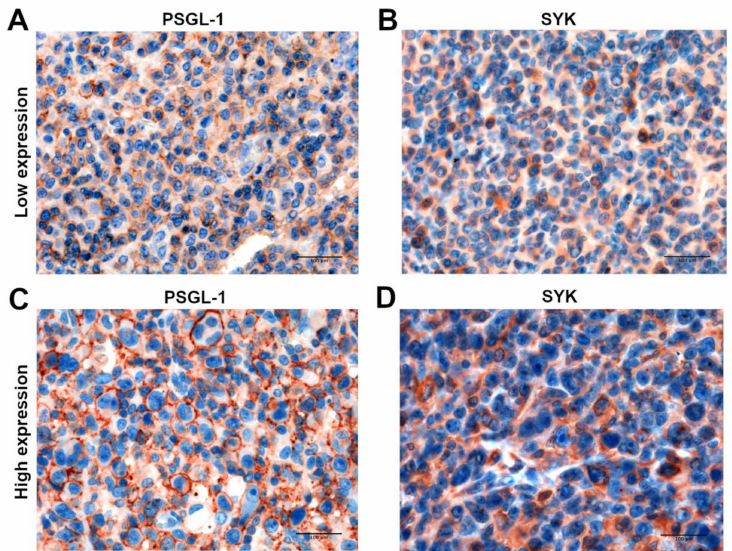
Figure 5. In situ IHC expression of PSGL-1 and SYK in prototypical ALCL cases. A similar pattern of expression was detected between PSGL-1 and SYK in ALCL cases by IHC assay: ALCL cases with a low expression level of PSGL-1 ( A ) showed also a lower expression of SYK ( B ), whilst highly expressing PSGL-1 samples ( C ) demonstrated comparable high levels of SYK ( D ). Scale bar: 100 µ m. These data strongly suggested that SELPLG signaling correlates with TCR signaling in ALCLs ( p -value ≤ 0.05) (Figure 6).